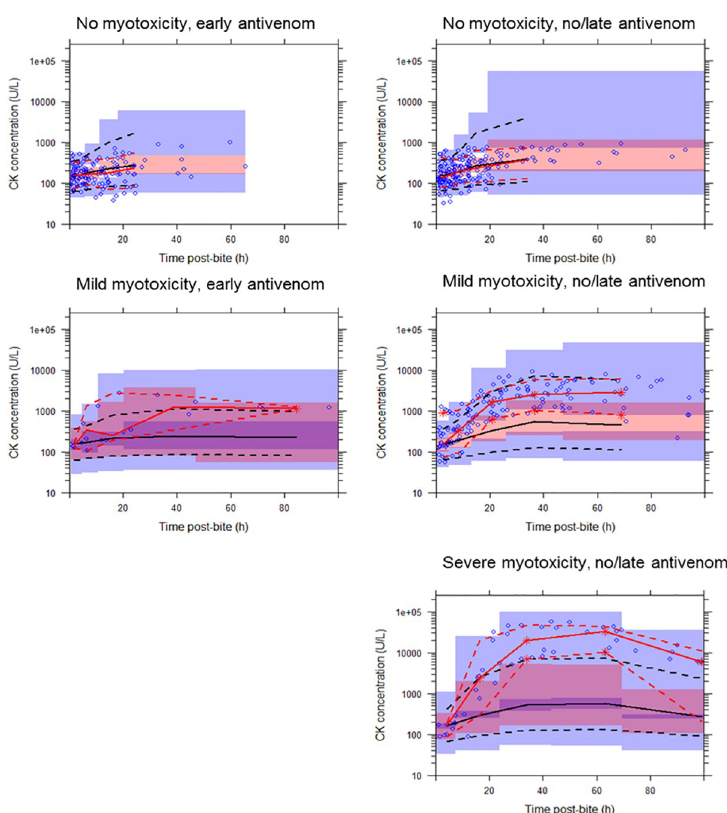
Fig 3. Visual predictive checks showing the observed timed creatine kinase (CK) concentration (U/L) versus time post-bite (h) described by a population pharmacokinetic-pharmacodynamic model with linear linker function to describe venom-effect relationship. The solid red line represents the median observed CK concentration, and the dashed lines represent the observed 10th and 90th percentiles. The solid black line represents the median simulated CK concentration, and the dashed lines represent the simulated 10th and 90th percentiles. Shaded areas are the corresponding 95% confidence intervals of the observed percentiles based on the simulated data. Patients data were categorised into three groups based on measured peak CK concentration: (a) no myotoxicity (CK < 1000 U/L); (b) mild myotoxicity (1000 U/L < CK < 10,000 U/L); and (c) severe myotoxicity (CK > 10,000 U/L). Plots on the left panel are for patients that received early antivenom (within 6 hours), and on the right are those that received no or late antivenom.